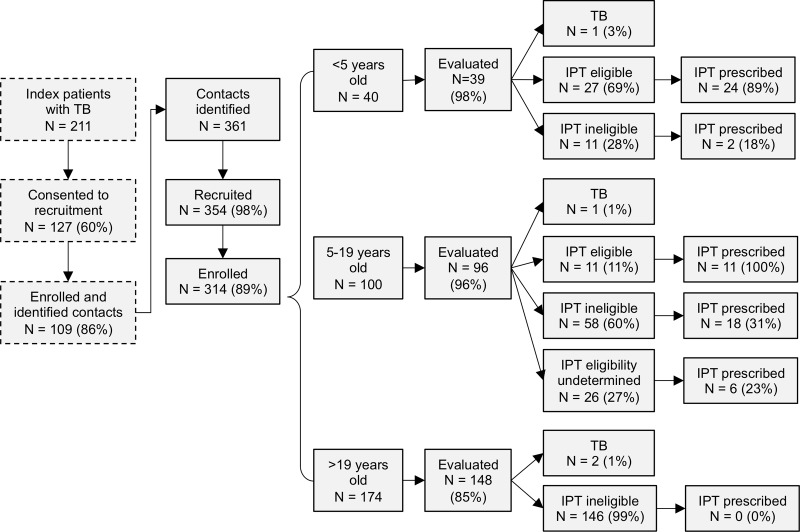
Participant enrollment and baseline evaluation results for contacts (N = 314).Contacts were eligible for isoniazid preventive therapy (IPT) if they were exposed to drug-sensitive pulmonary TB and either <5 years old or 5–19 years old with a positive tuberculin skin test (TST) result. Contacts exposed to drug-resistant or extrapulmonary TB were ineligible for IPT. Contacts 5–19 years old without a TST were categorized as having undetermined IPT eligibility.